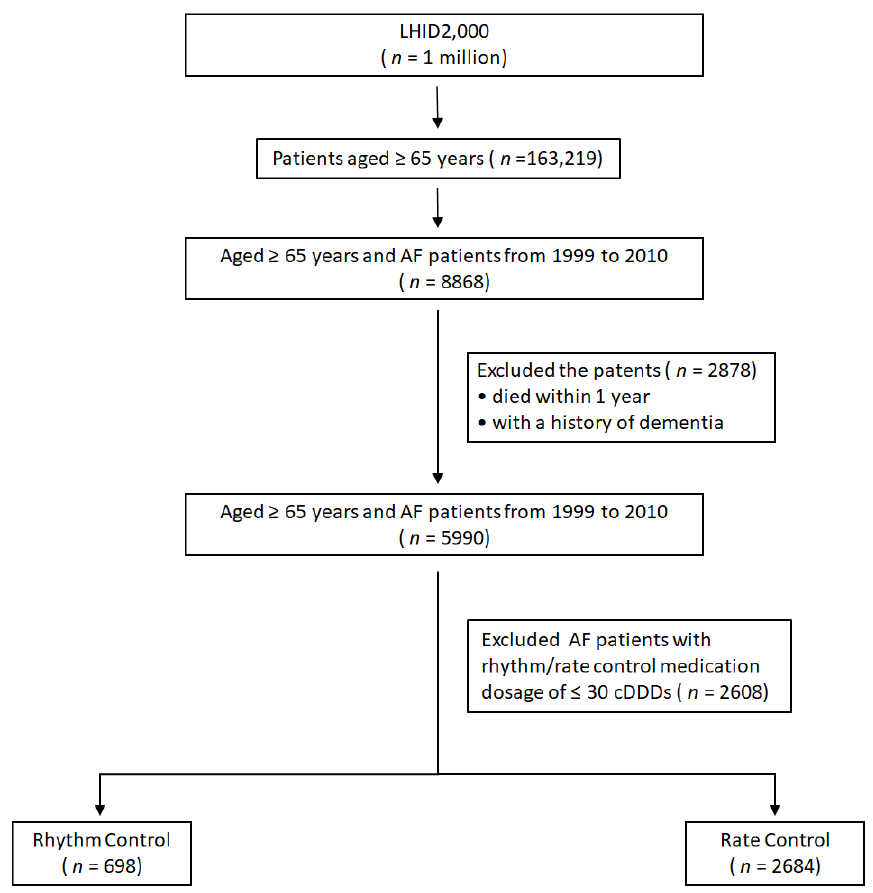
Figure 1. Flow chart of the study population. AF, atrial fibrillation; LHID, longitudinal health insurance database; cDDD, cumulative defined daily dose.